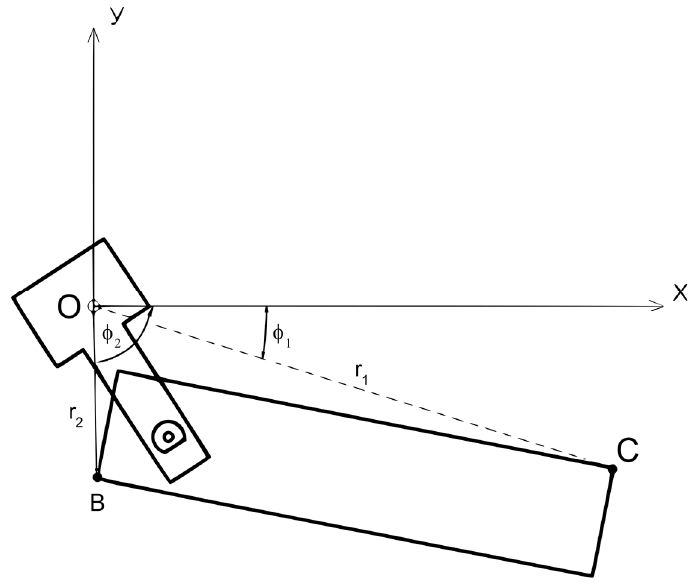
Figure 6. The layout of points O, B and C on the truck.